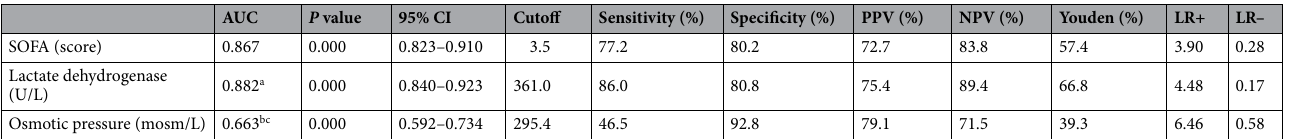
Table 6. Performance of lactate dehydrogenase, osmotic pressure, and SOFA score on ICU admission in predicting 28-day all-cause mortality in older adult patients with COVID-19. AUC, area under the receiver operating characteristic curve; CI, confidence interval; COVID-19, coronavirus disease 2019; ICU, intensive care unit; LR+ , positive likelihood ratio; LR–, negative likelihood ratio; NPV, negative predictive value; PPV, positive predictive value; SOFA, Sequential Organ Failure Assessment. a P = 0.5744 (Z = 0.562) versus SOFA. b P < 0.0001 (Z = 5.505) versus SOFA. c P < 0.0001 (Z = 5.607) versus lactate